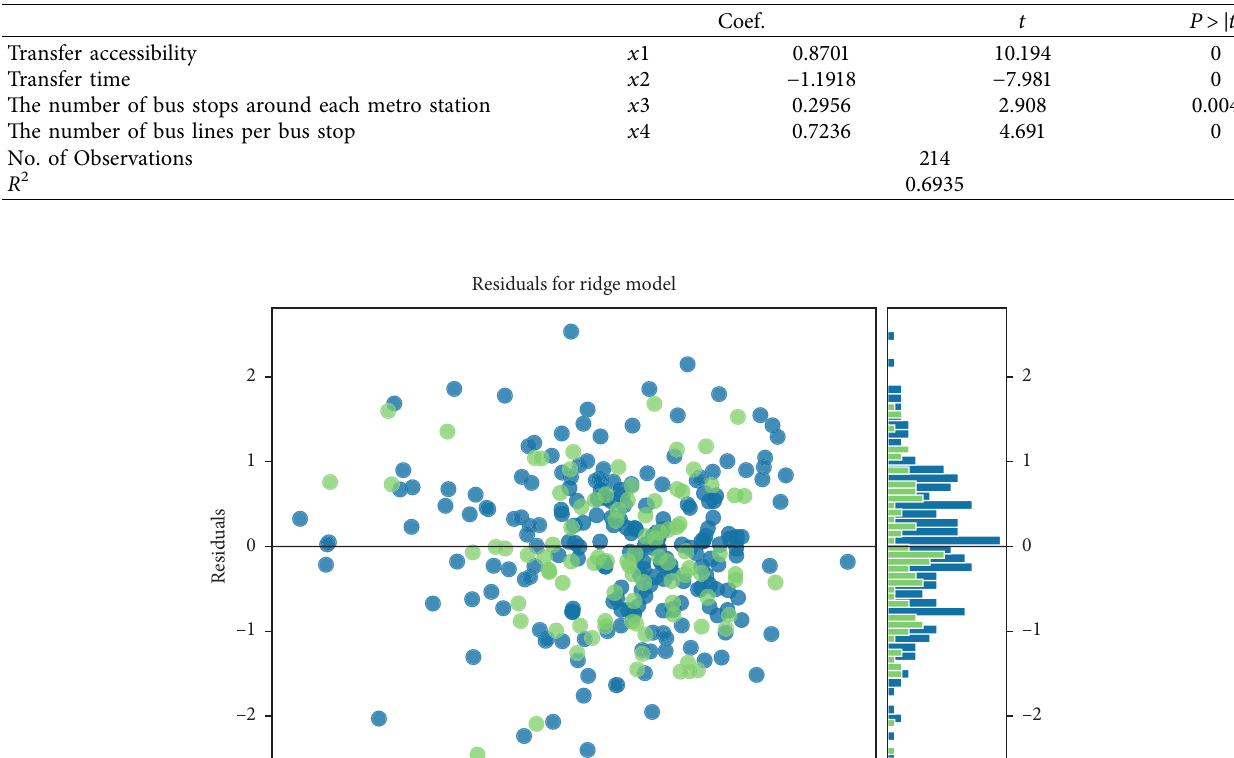
Table 5: Estimation results of the regression model based on the training set.